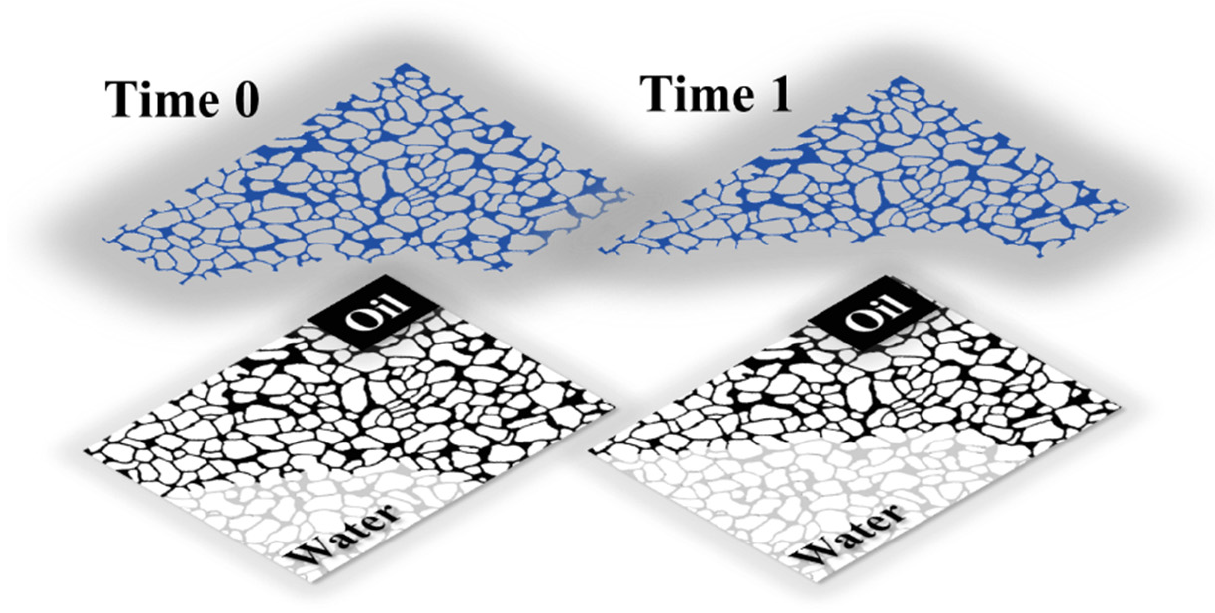
Figure 3. The representation of the recovery ration of the micromodel.